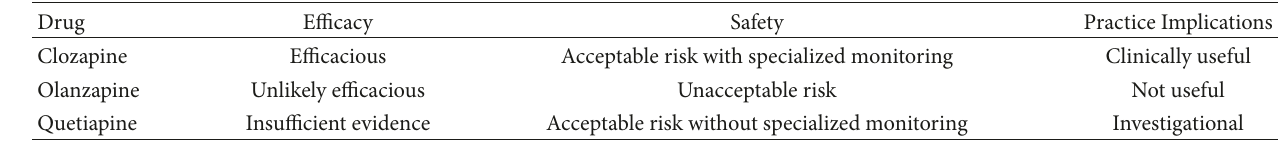
Table 6: Summary of commonly used antipsychotic drugs to treat PD